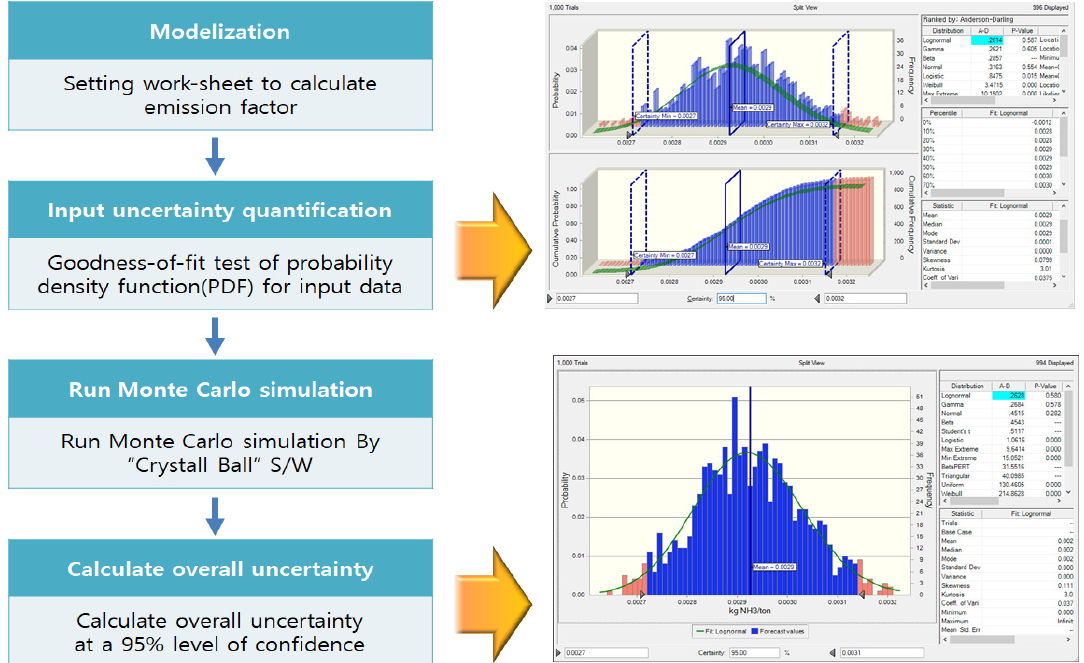
Figure 2. Process of the Monte Carlo Simulation for estimating the uncertainty of the emission factor.